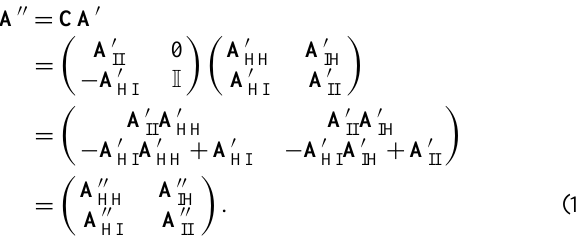
Table 4. Same as Table 3 but after applying the a posteriori operator of Eq. (14).